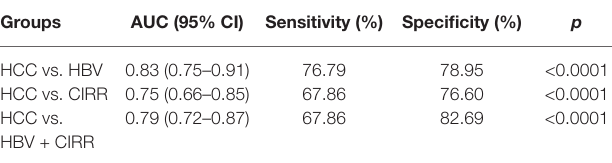
TABLE 3 | The diagnostic performance of has_circ_0028861 for HCC detection.